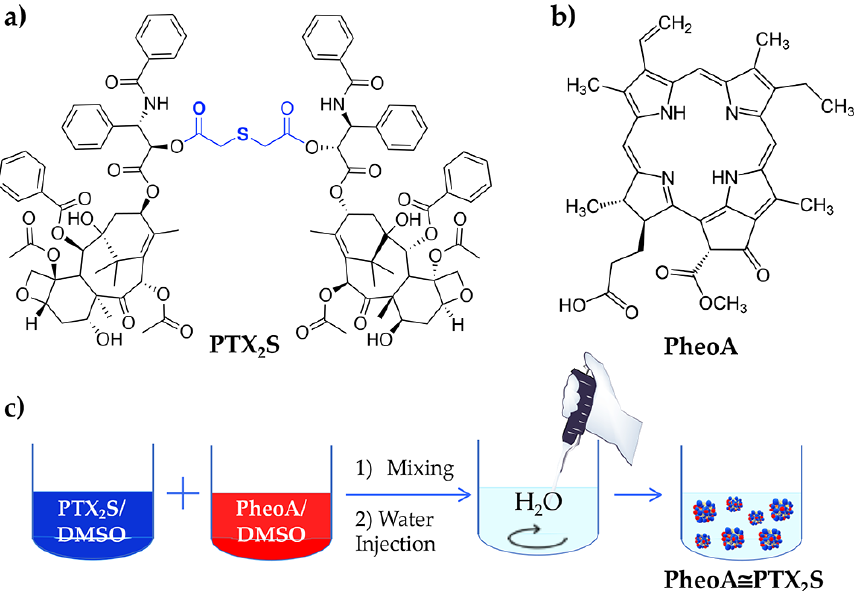
Figure 1. ( a ) Chemical structure of PTX 2 S; ( b ) Chemical structure of PheoA; ( c ) Schematic representation of PheoA ≅ PTX 2 S preparation by the nanoprecipitation method.